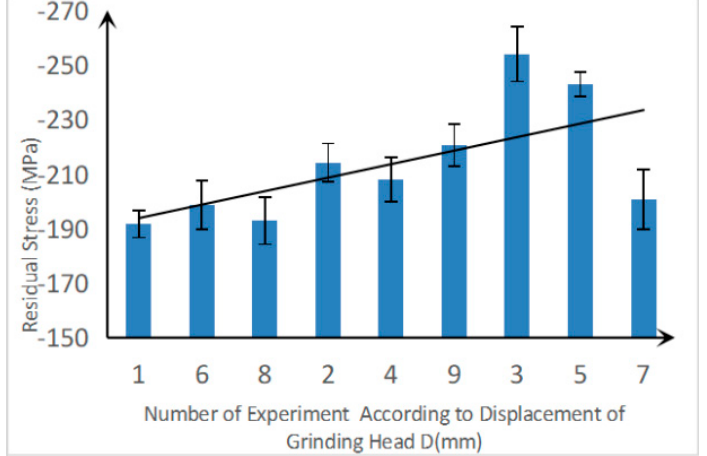
Figure 16. Relationship between the surface residual stress and the amount of downward movement of the grinding head.